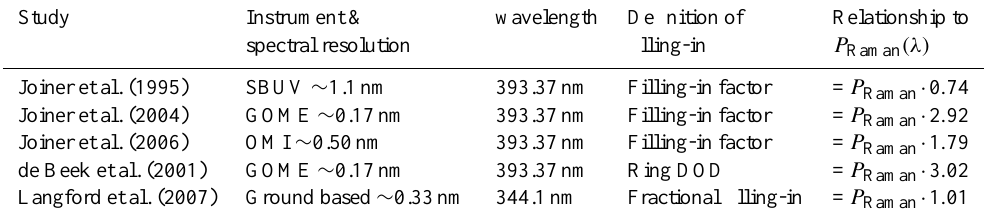
Table 2. Relationship between the Raman scattering probability (RSP) and other definitions of the filling-in (see also Wagner et al.,